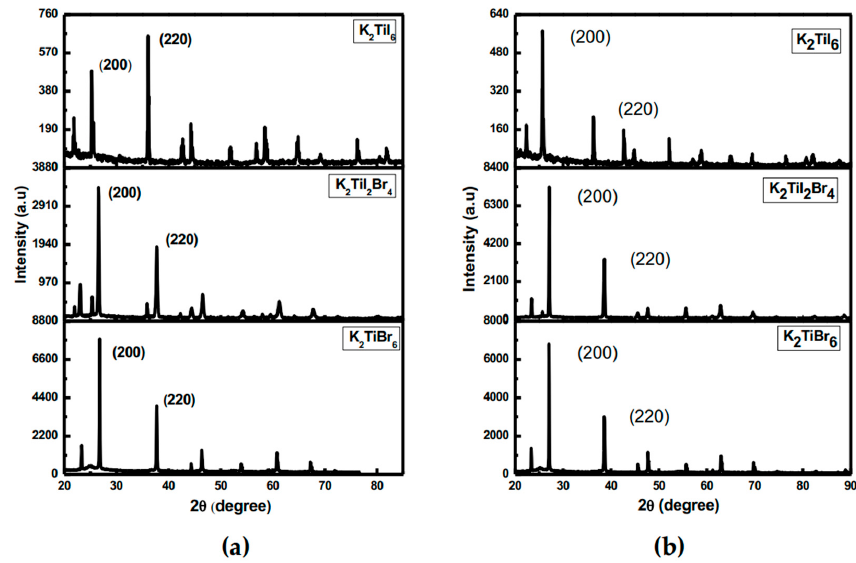
Figure 1. XRD pattern of K 2 TiI 6, K 2 TiI 2 Br 4 and K 2 TiBr 6 ( a ) when prepared ( b ) after 10 months.